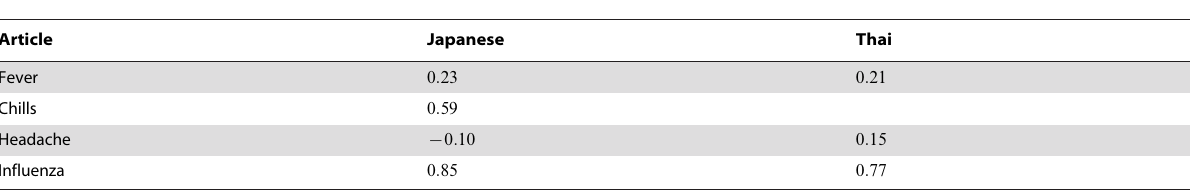
Table 2. Transferability r t